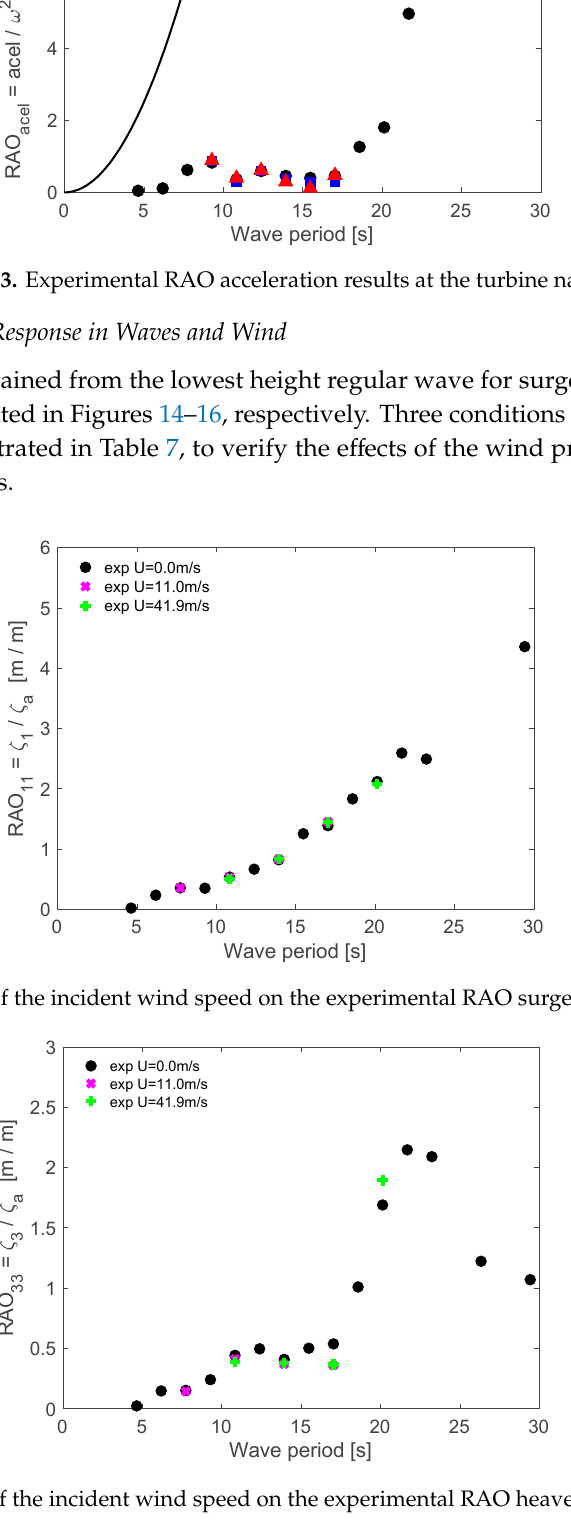
Figure 16. Effect of the incident wind speed on the experimental RAO pitch motion results.